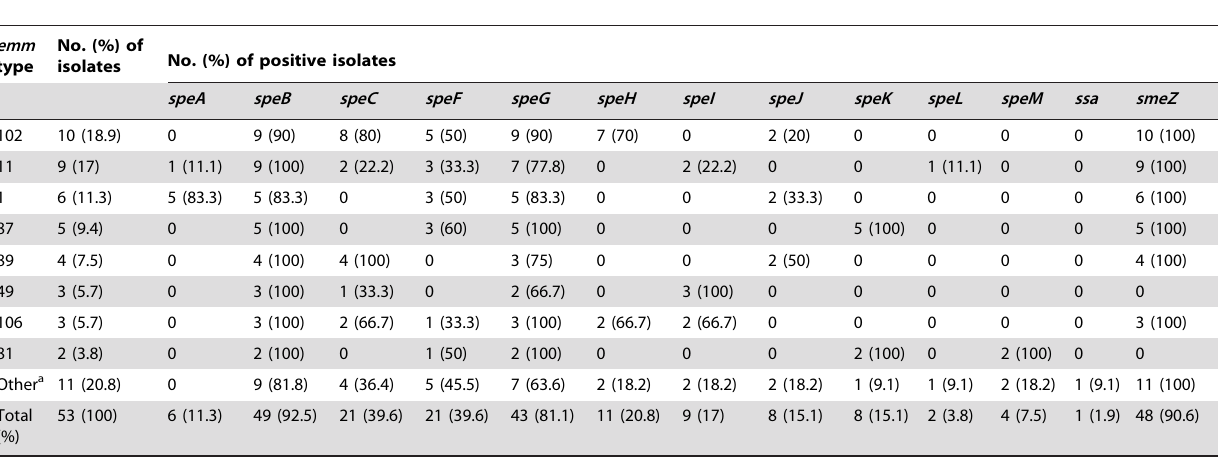
Table 5. Superantigen Genes in Streptococcus pyogenes That Caused Toxic Shock Syndrome.